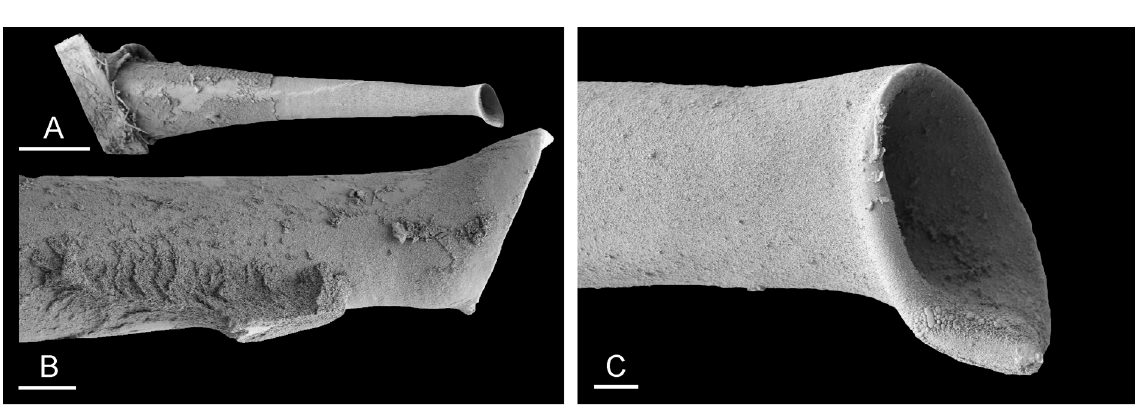
free oviduct conveys the eggs up to the female opening and the exosperm from the female opening up to the fertilization chamber. The large, ovate-spherical spermatheca connects to the oviduct through a narrow and short duct. The oviduct is narrow and straight. There is no vaginal gland.